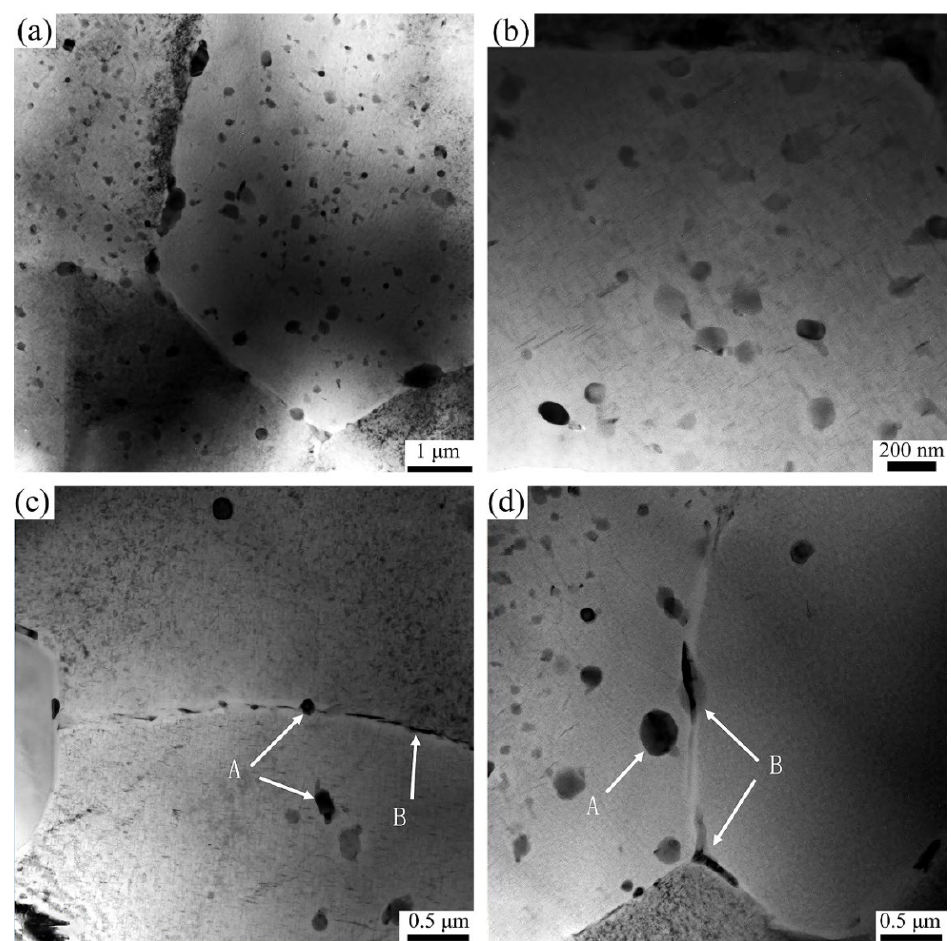
Figure 7. TEM images showing grain boundary and intracrystalline phases. ( a , b ) show the distribu- tion of phases. The morphologies of the grain boundary and intragranular phases are shown in ( c , d ). The high-resolution results images showed that the width of the precipitated phase increased from several atomic layers (1–4 in Figure 8e,f) to several nanometers, and then to more than ten nanometers (5–6 in Figure 8f), and the precipitated phase was coherent with the matrix. The precipitated phase gradually grew from initial atomic clusters, forming areas 1–4, and then continued to grow, forming areas 5–6. The precipitated phase grew in both length and width, but its length grew more rapidly. Reports have shown that the precipitation sequence of the θ phase follows: SSS → GP region → θ (cid:48)(cid:48) phase → θ (cid:48) phase → θ (cid:48) phase, where SSS is a supersaturated solid solution [23,24]. Therefore, the θ (cid:48) phase formed after the formation of the θ (cid:48) phase, with the enrichment of copper atoms. The θ (cid:48) phase was the transition phase of θ and had a tetragonal lattice. The coherent relationship between the θ (cid:48) phase and the matrix was maintained by the {100} plane. When the coherent relationship between the θ (cid:48) phase and the matrix started to dissociate, the coherent relationship became semi-coherent, causing the alloy to soften. With the formation and growth of the θ phase, the θ phase completely dissociated from the coherent relationship with the matrix, and the strength of the alloy continued to